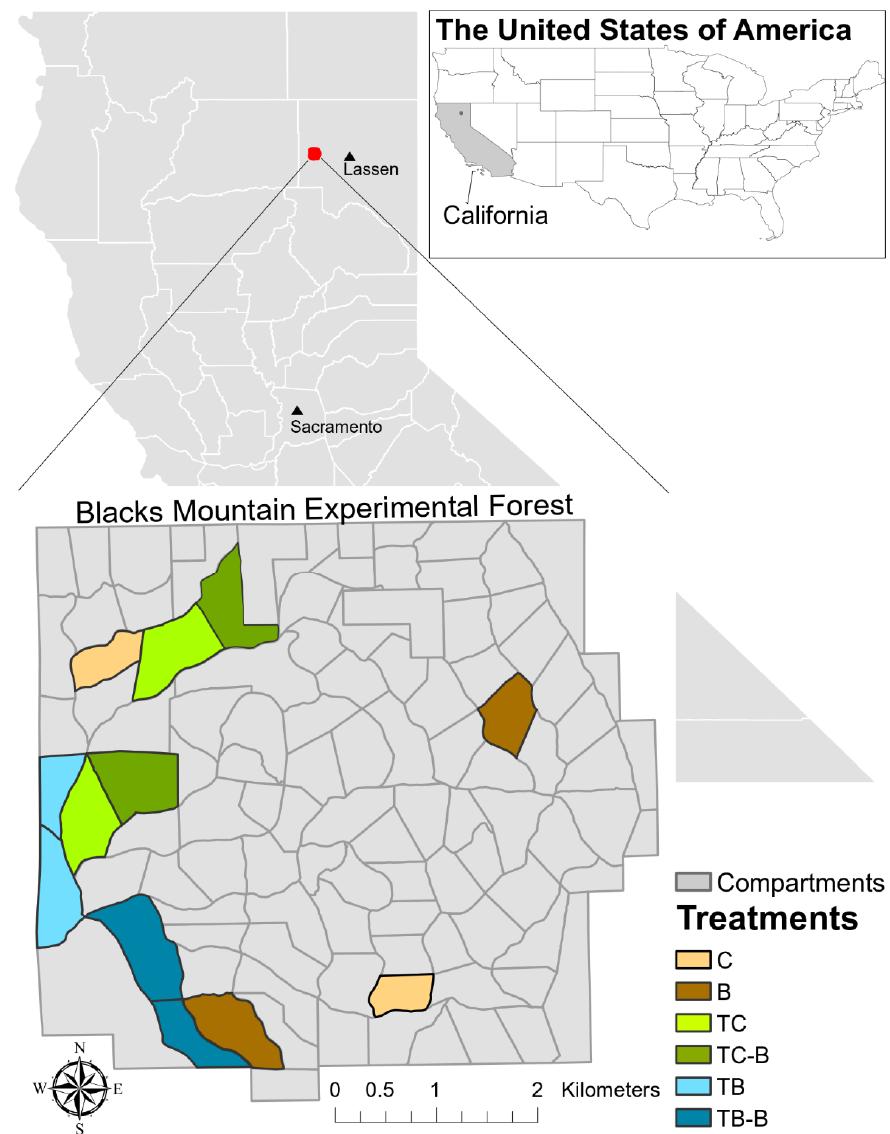
Figure 1. Location of Blacks Mountain Experimental Forest (BMEF) in northern California with 100 compartments and six management treatments. Treatments were applied at the compartment level. C: control, B: prescribed fire (1999/1997, 2011), TC: combination thinning (1996), TC-B: combination thinning (1996) with prescribed fire (1997), TB: thinning from below (2012), TB-B: thinning from below (2012) with prescribed fire (2017).